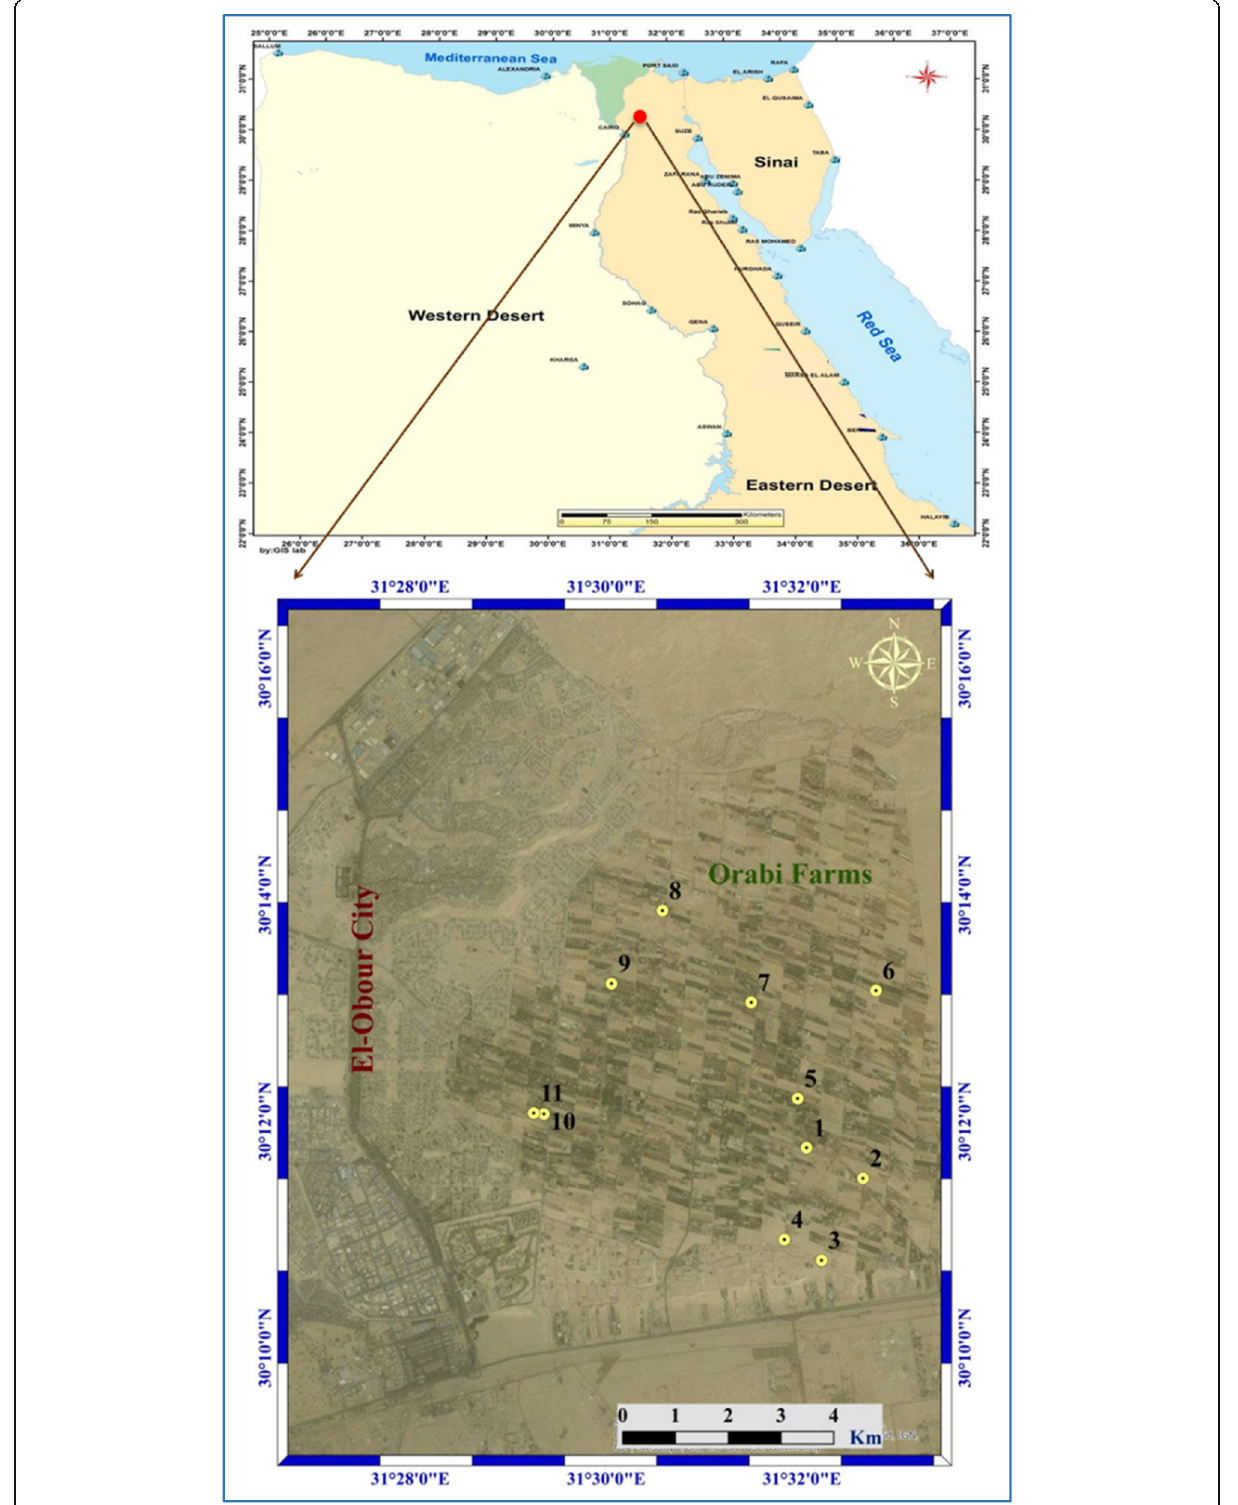
Fig. 1 Location map of the collected soil samples in the study